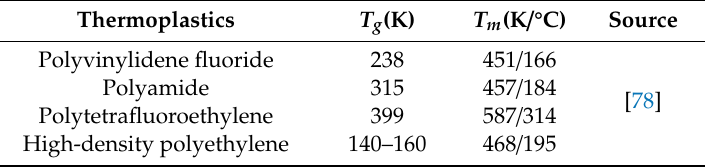
Table A2. Glass transition and melting temperature of